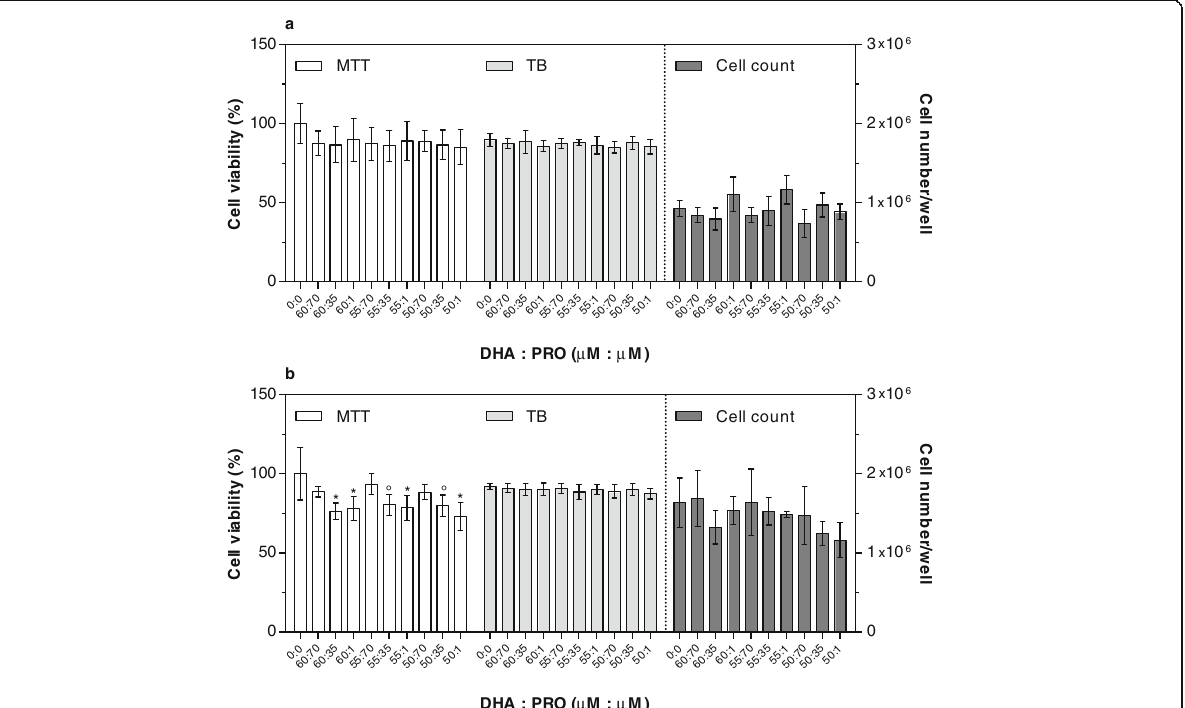
Fig. 6 Cytotoxic effects of DHA plus PRO after 24 ( a ) and 48 ( b ) hours of supplementation. Cell viability by MTT is expressed as percentage of control cells (assigned as 100%). TB is expressed as percentage of total cells. Cell count is expressed as number of cells per well. Data are means ± SD of six samples obtained from two independent experiments. Statistical analysis was by the one-way ANOVA (panel a : MTT, TB, and cell count n.s.; panel b : MTT p < 0.001, TB, and cell count n.s.) using Dunnett ’ s as post-test to compare supplemented cells to control ones (° p < 0.01; * p <